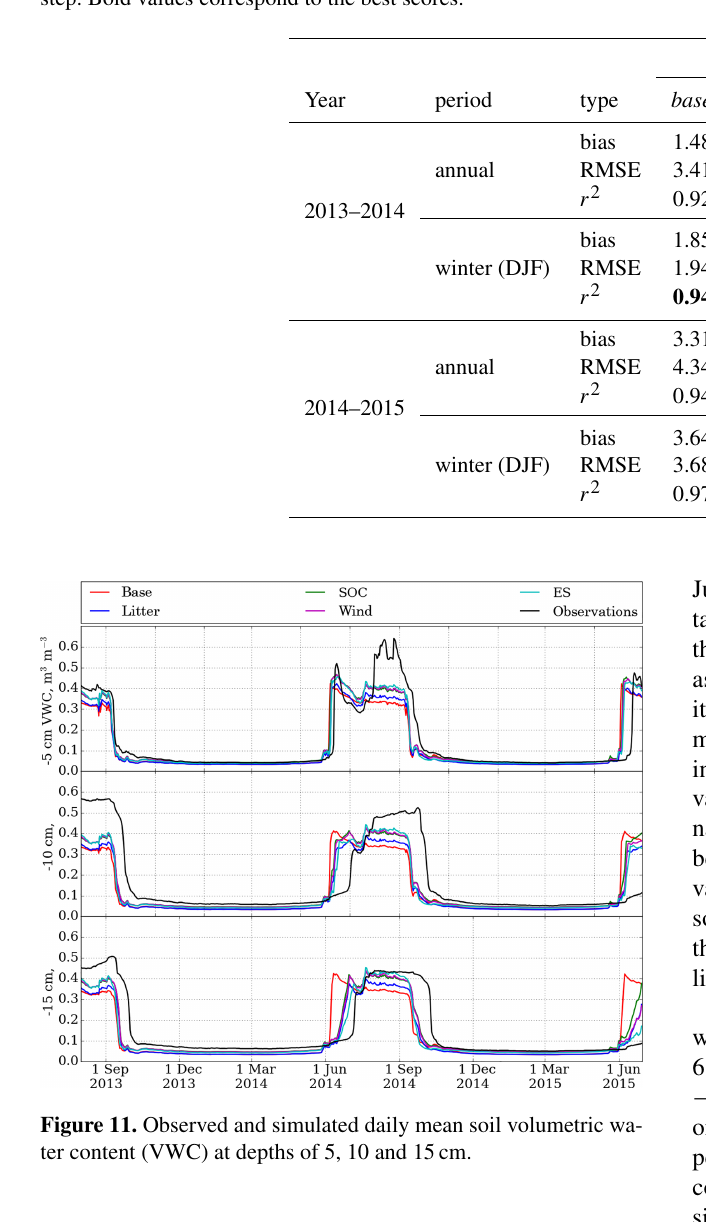
Table 2. Statistical indicators of the differences between observations and model results of the soil temperature ( ◦ C) at − 15cm on a 6h time step. Bold values correspond to the best scores.